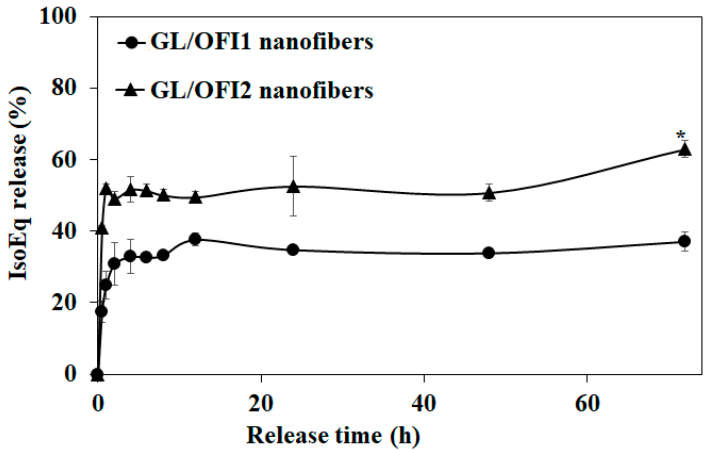
Figure 7. Cumulative release of isorhamnetin glycosides from FS fibers prepared with 25% or 30% gelatin and OFI extract. (*) Significant difference by Student’s t -test, n = 3 ( p < 0.05).